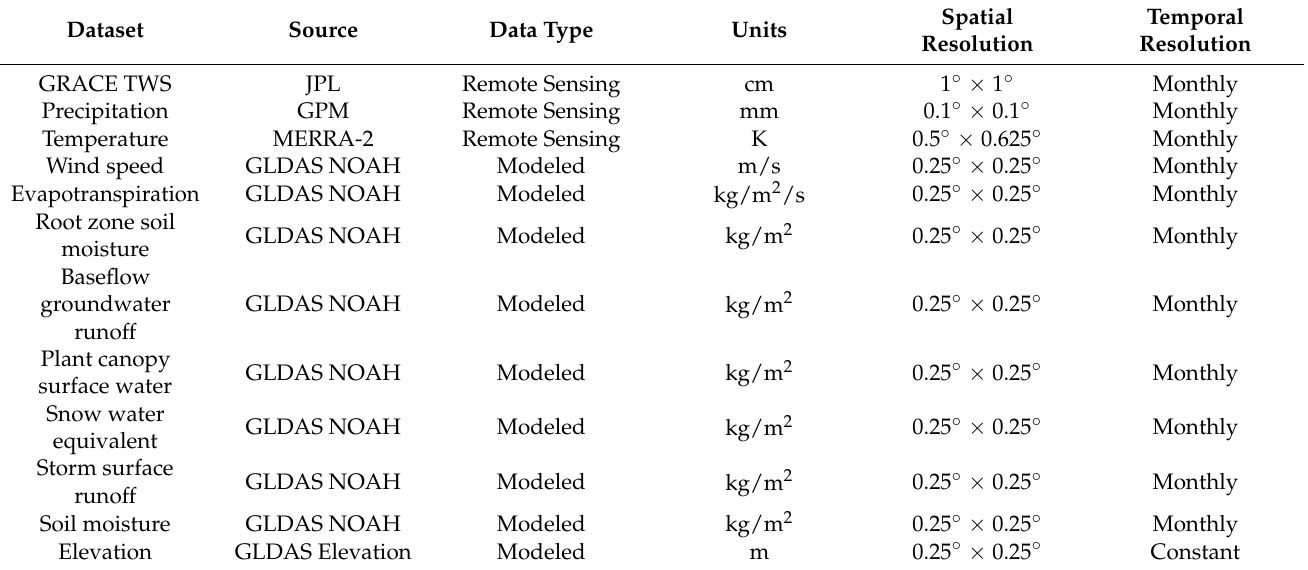
Table 1. Summary of input data used to estimate